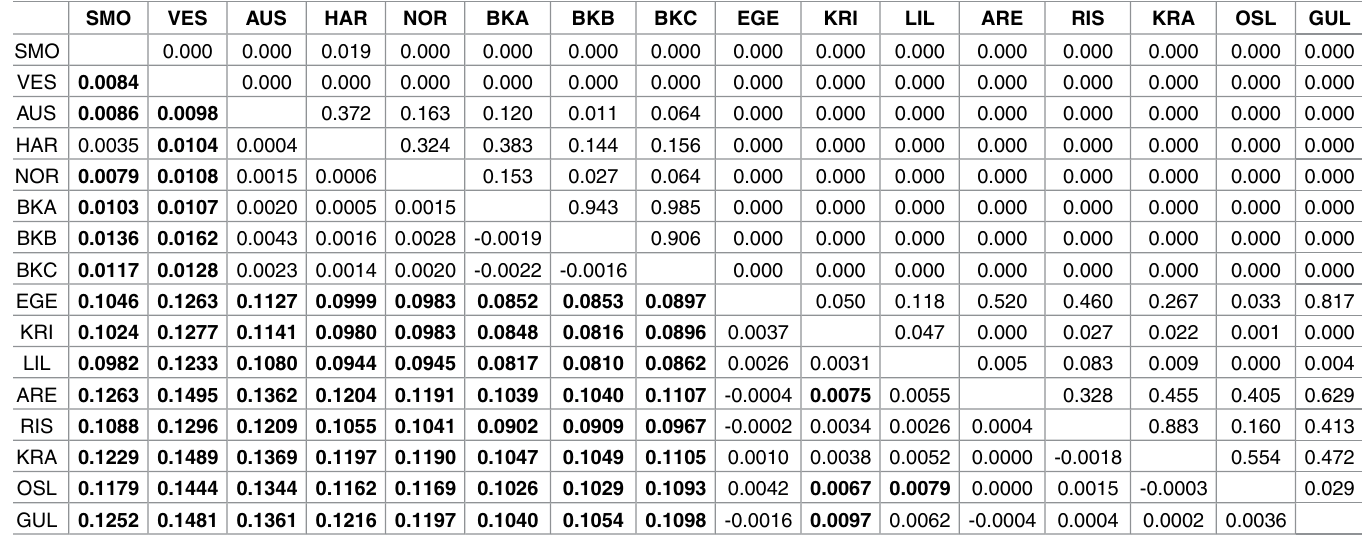
Table 2. Pairwise comparisons amongcorkwingwrassesamplelocalities withinand across the threegeneticbreaks. Values below the diagonal are F ST estimatesfor all samplepairsand above the diagonalare the corresponding P -values. Numbersin bold indicatestatisticalsignificant tests at 5% level afterthe False Discovery Rate approach[47].